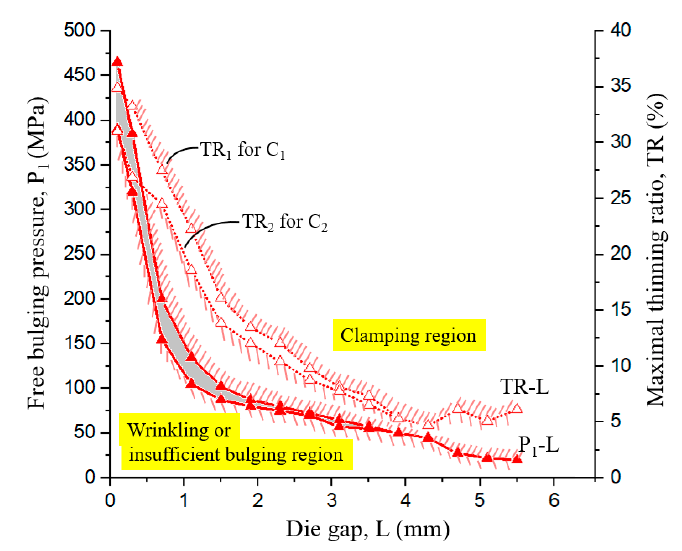
Figure 11. Forming windows for feeding type 2.